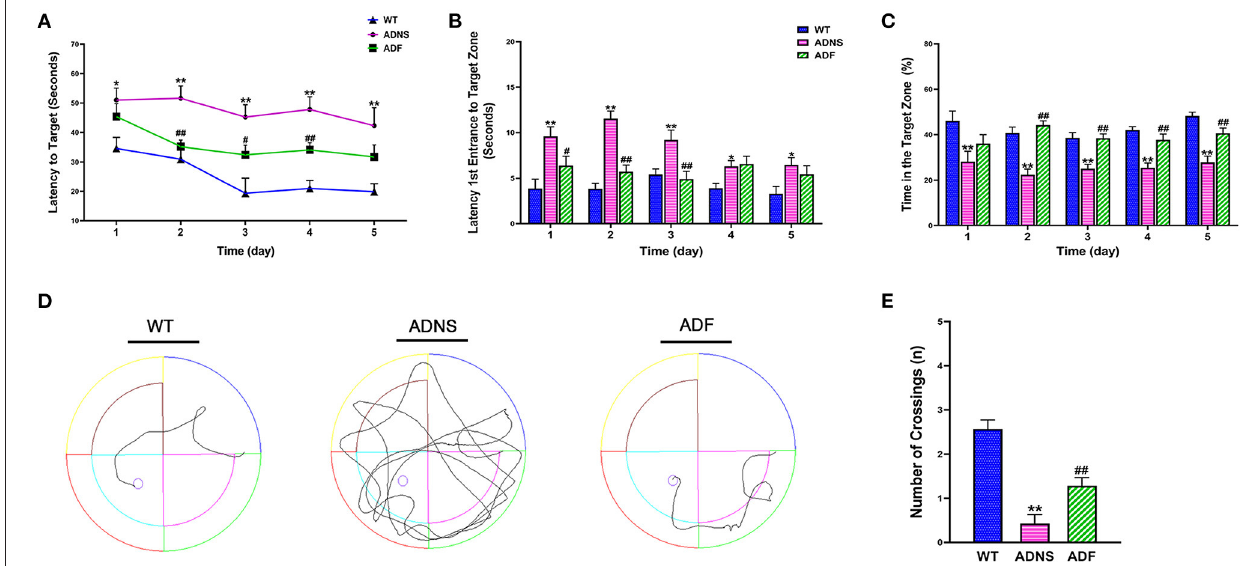
FIGURE 1 | Effects of fasudil on learning and memory of APP/PS1 mice in the Morris water maze test. (A–C) Changes in escape latency (A) , latency of first entrance to the target zone (B) , and the total time (%) spent in target zone (C) during the 5-d acquisition training in WT, APP/PS1 mice treated with saline (ADNS) or fasudil (ADF). (D) Representative swimming paths of WT, ADNS, and ADF mice in the probe trial. (E) The number of crossings into the border of the target zone in the probe trial. Data presented are the means ± SEM; n = 7; * p < 0.05, ** p < 0.01 vs. WT; # p < 0.05, ## p < 0.01 vs.